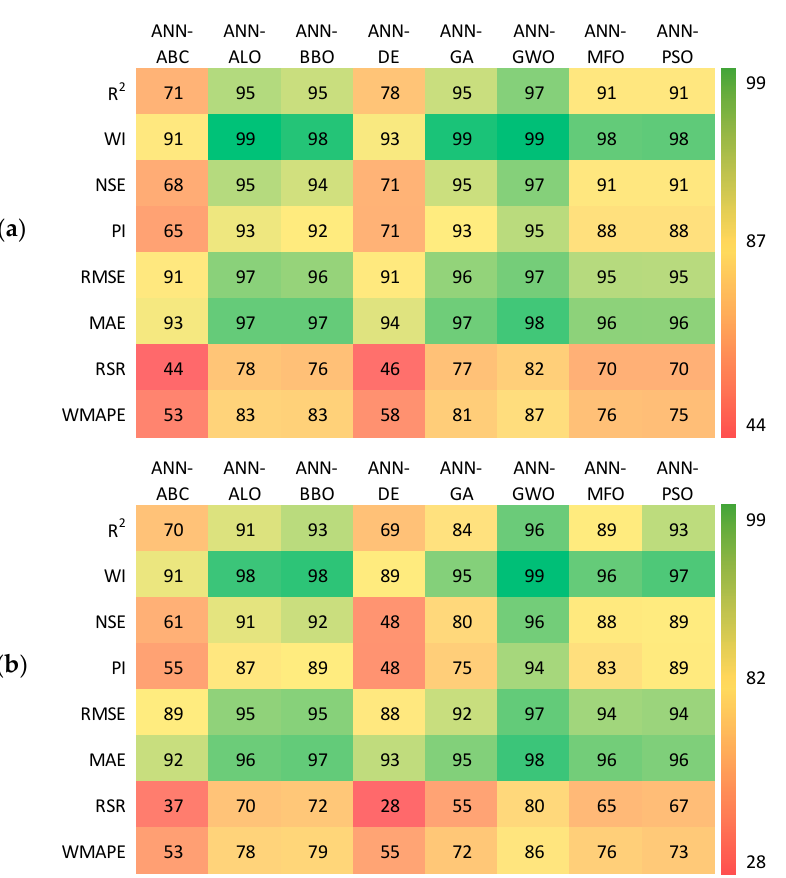
Figure 11. Accuracy matrices for the: ( a ) training phase and ( b ) testing phase.